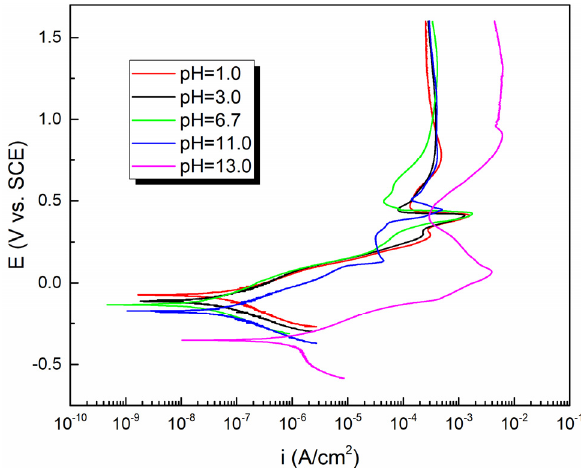
Figure 4. The PDP curves of galena in of NaCl solutions with different pH values.